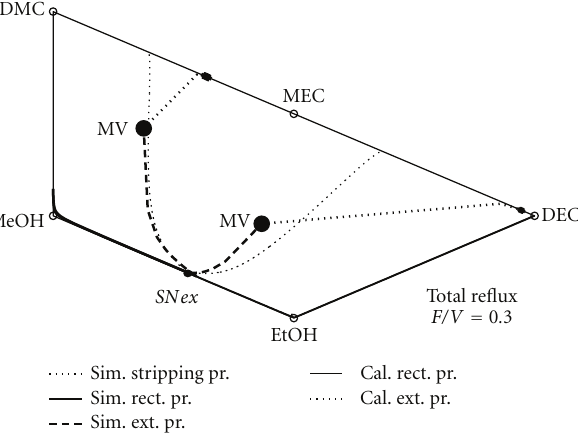
Figure 11: Simulated and calculated profiles at total reboil ratio, at /V = 0 . 2. R = 5 and at F d